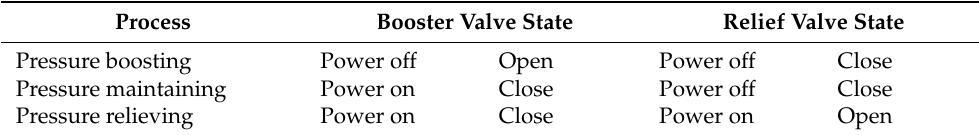
Table 2. Air pressure control logic of single wheel braking.